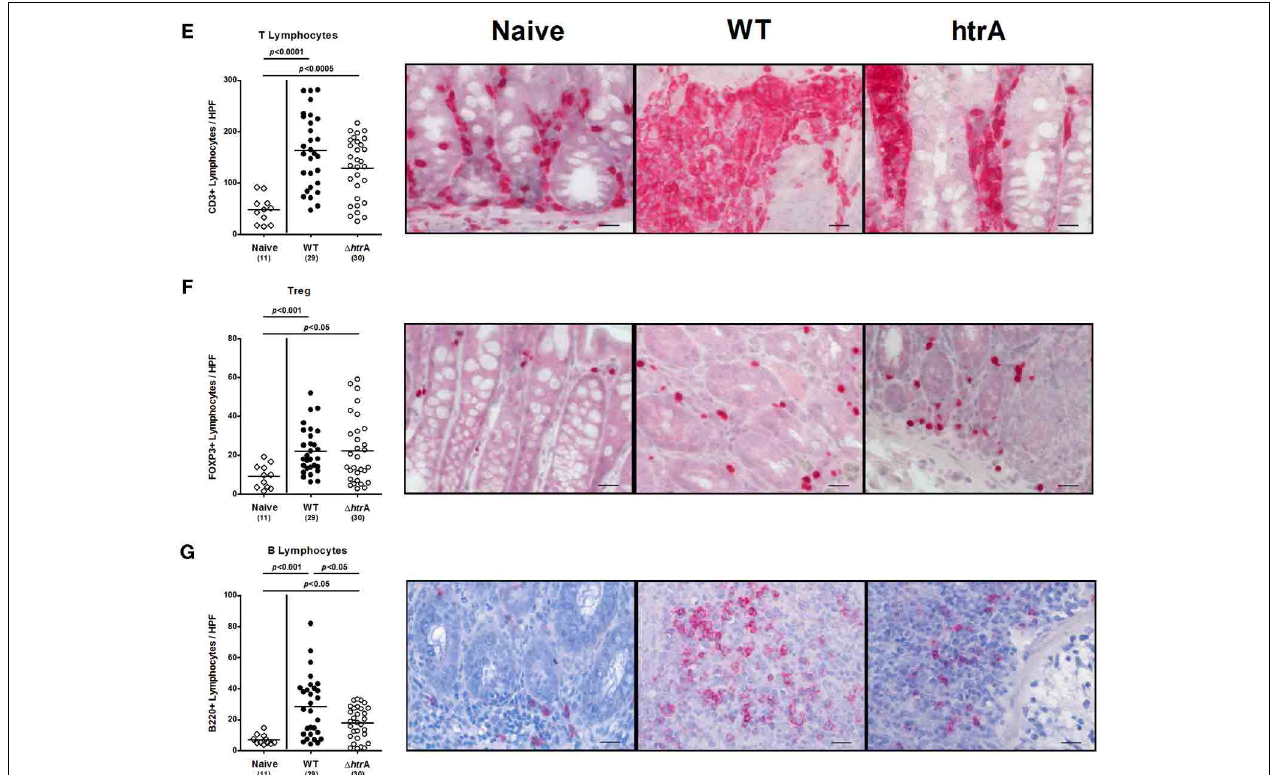
FIGURE 3 | Colonic inflammatory, regenerative, and immune cell responses in gnotobiotic IL-10 − / − mice following infection with wild-type and (cid:2) htrA mutant C. jejuni . The average numbers of apoptotic cells [positive for caspase-3, (A) ], proliferating cells [positive for Ki67, (B) ], neutrophils [positive for MPO7, (C) ], macrophages and monocytes [positive for F4/80, (D) ], T lymphocytes [positive for CD3, (E) ], regulatory T cells [Treg,